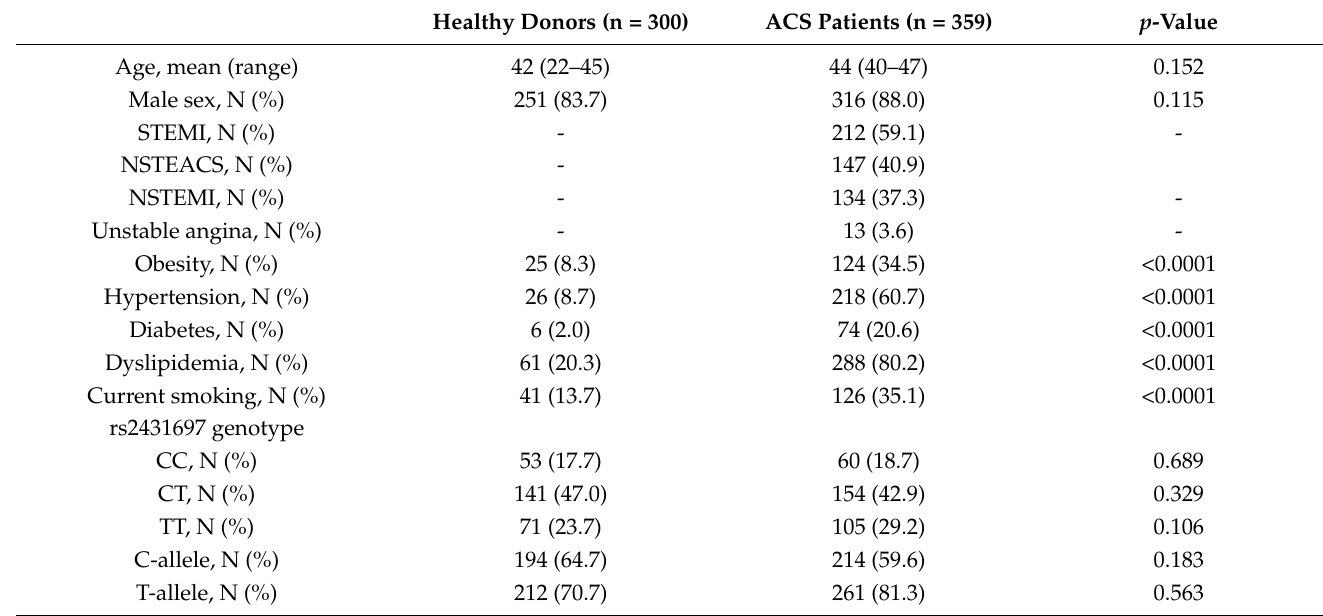
Table 1. Age, sex, main clinical characteristics and rs2431697 genotype of the ACS cohort vs. healthy